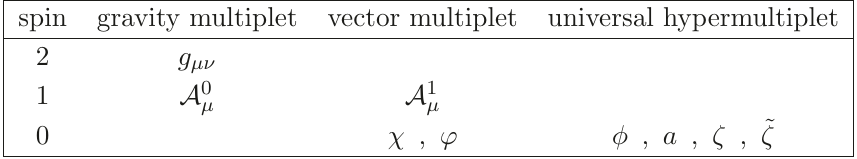
= 2 and SU(3)-invariant subsector of the maximal supergravity N